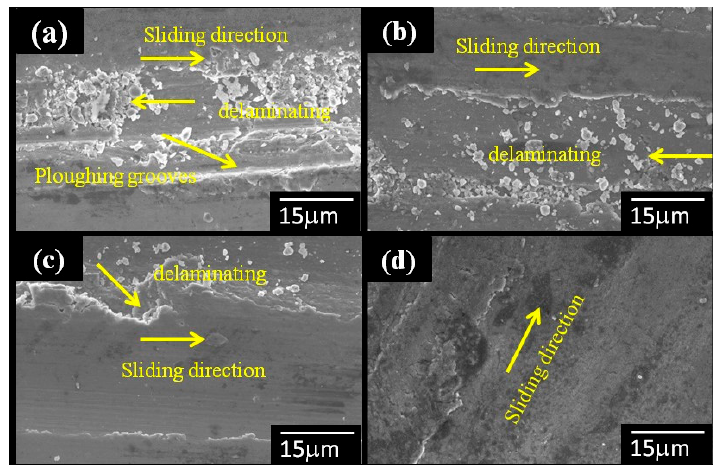
Figure 4. SEM micrographs showing the wear morphology of worn surfaces of composites reinforcement with classified particle size ( a ) 80–100 µ m; ( b ) 40–80 µ m; ( c ) 20–40 µ m and ( d ) 0–20 µ m.